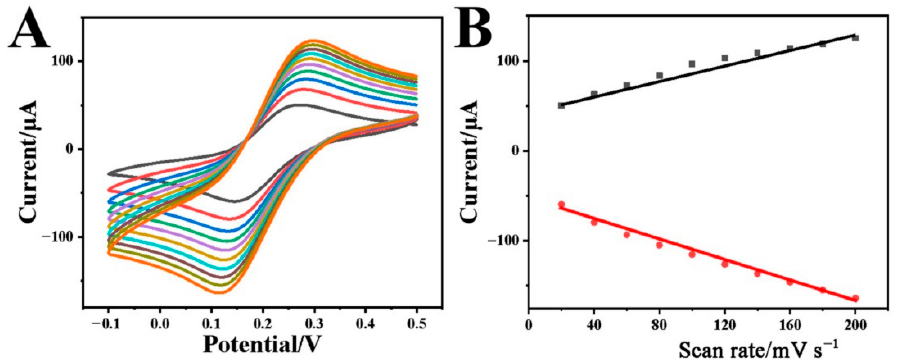
Figure 3. ( A ) CVs of the Cr-MOF/GCE in the solution containing 0.1 M KCl with 2 mM [Fe(CN) 6 ] 3 − /4 − at the scan rates varying from 20 to 200 mV s − 1 and ( B ) the corresponding relationships between anodic/cathode peak current and scan rate.